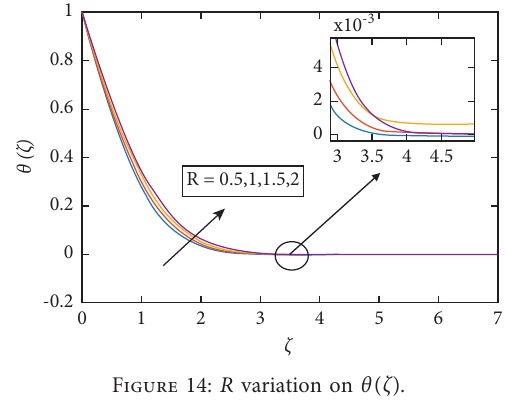
Figure 11: M variation on θ ( ζ ) .